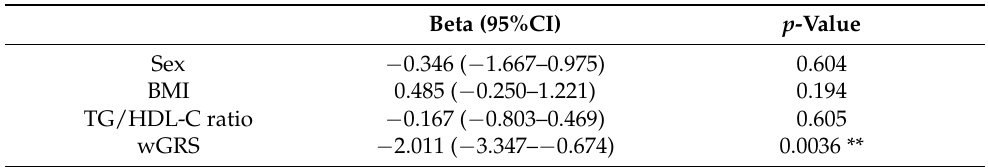
Table 6. Results of the linear regression model of AORS’s components on the age of onset for T2DM Figure 4. The proportion of components (sex, BMI, TG/HDL-C ratio, and wGRS) of the age of on- in the Hungarian general population’s type 2 diabetic set risk score in the Hungarian general population by subpopulations.